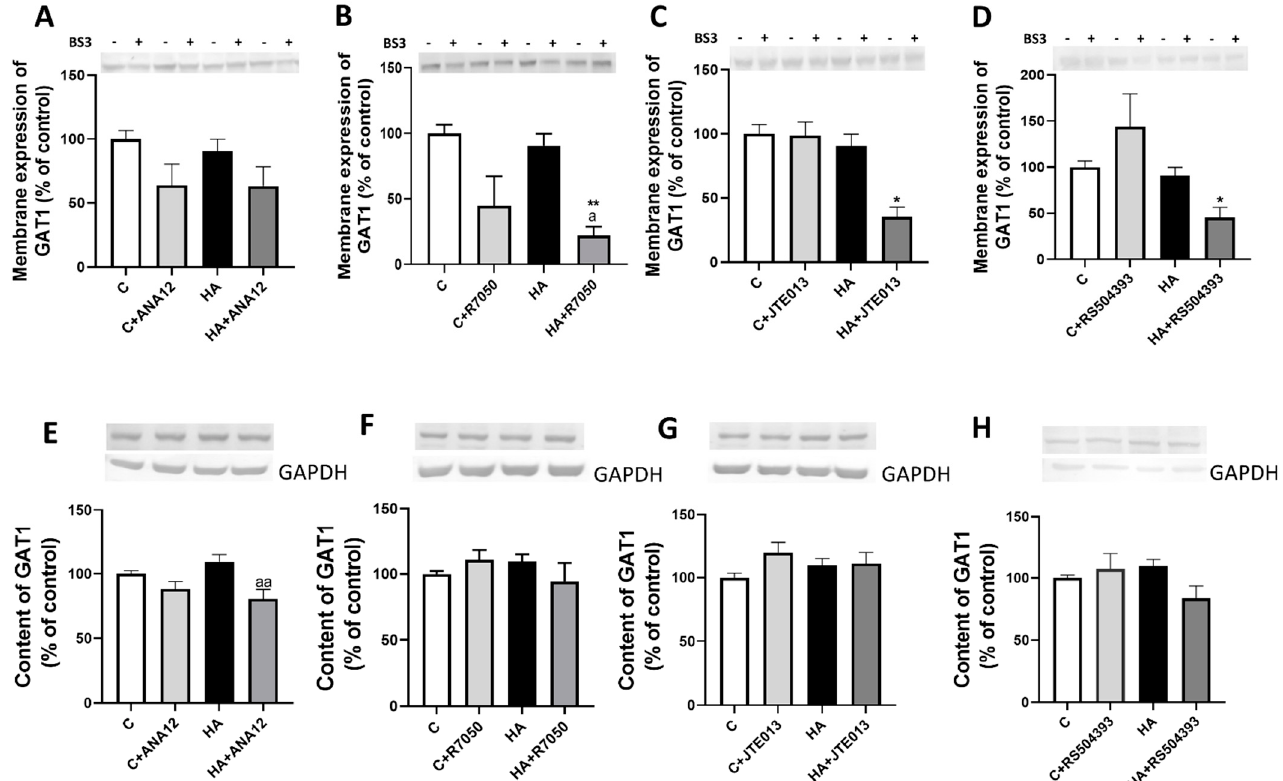
Figure 6. Hyperammonemia does not affect the membrane expression and content of GAT1. ( A – D ) The membrane expression of GAT1 was analyzed using a BS3 cross-linker procedure in slices from control (C) and hyperammonemic (HA) rats. The effects of blocking TrkB with ANA12, TNFR1 with R7050, S1PR2 with JTE-013, and CCR2 with RS504393 on the membrane expression of GAT1 are also shown. ( E – H ) Total content of GAT1 was analyzed with Western blot in slices from control and hyperammonemic rats treated or not with ANA12, R7050, JTE-013, and RS504393. Actin or GAPDH were used as the loading control. Values are the mean ± SEM of ( A – D ) 23–32 rats and ( E – H ) 17–25 rats per group. Values significantly different from control rats are indicated with asterisks, and from hyperammonemic rats are indicated with “a”. * p < 0.05, ** p < 0.01; a p < 0.05, aa p < 0.01. ( A – H ) F values were 2.681, 6.521, 2.793, 5.908, 5.711, 1.371, 1.371, 1.536, and 2.566, respectively. Data were analyzed using one-way analysis of variance (ANOVA) followed by Tukey’s post hoc